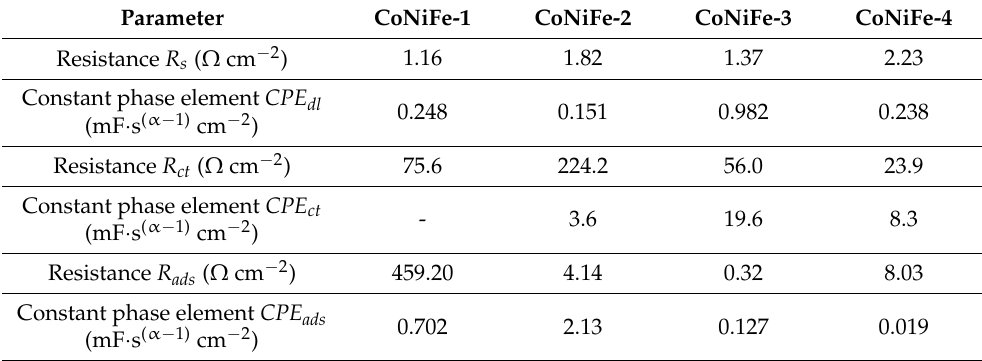
Table 3. Characteristic parameters of aqueous suspensions of Co-Ni-Fe